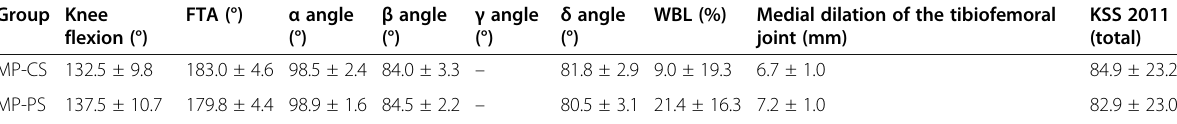
Table 1 Comparison of preoperative knee flexion angle, bone morphologic angles, and clinical outcome Group Knee flexion (°)